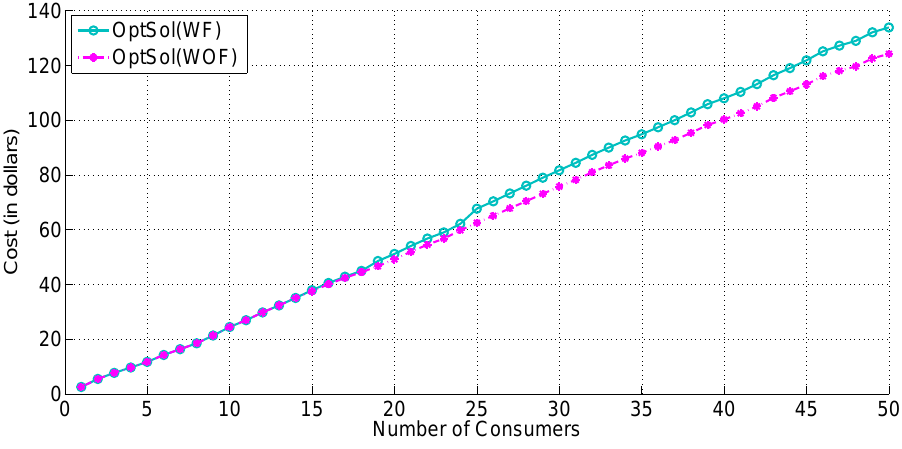
Figure 10. Sum Cost Comparison of both Proposed Schemes.